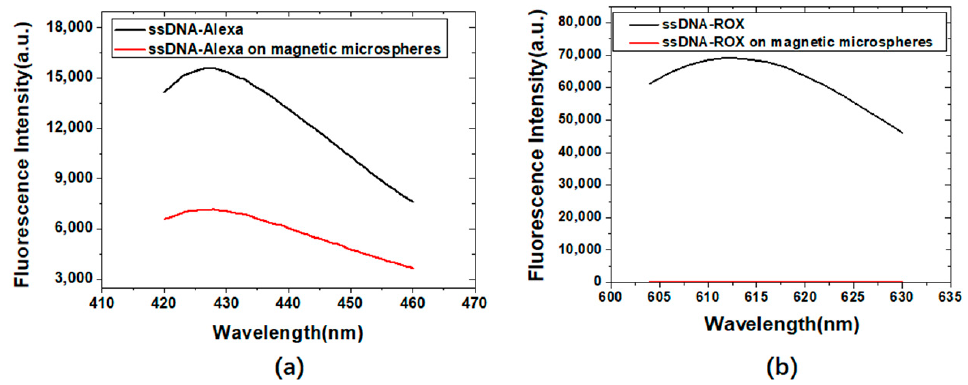
ROX. ROX was selected to label the abrin aptamer.